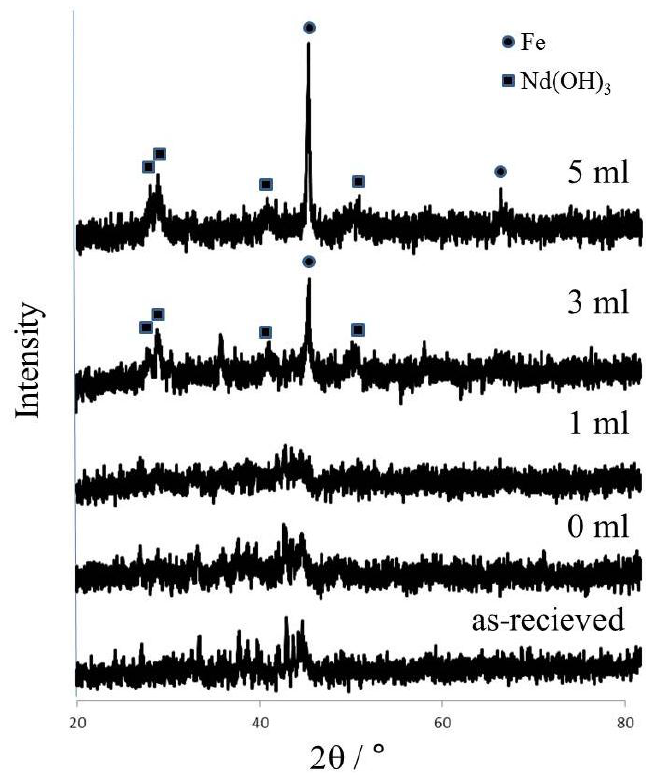
Figure 1. XRD patterns of ground products with water addition (Grinding conditions: 15 in stoichiometric molar ratio, 550 rpm in rotational speed, 30 min in grinding